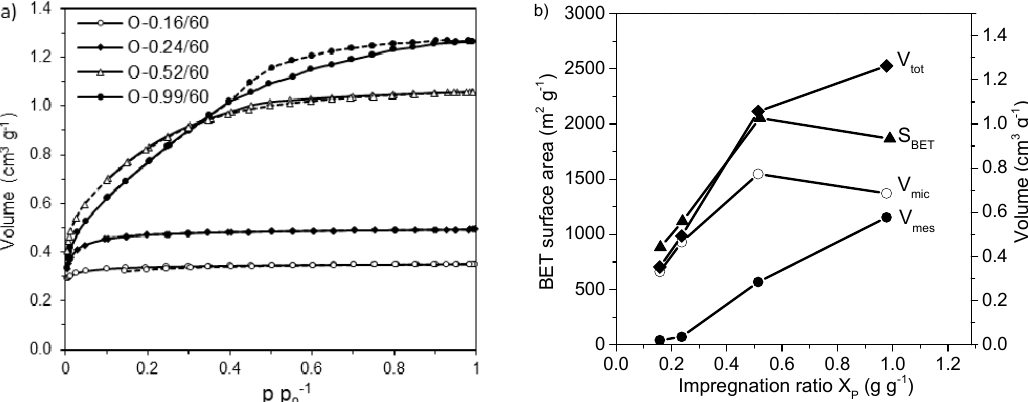
Figure 15. Adsorption (-) and (---) desorption N 2 isotherms at 77 K ( a ) and variations in the BET surface area (S BET ), total pore volume (V T ), micropore volume (V mic ), mesopore volume (V mes ) ( b ) for ACs from oak prepared by phosphoric acid activation at different impregnation ratio (g P/g precursor). Reproduced from [4] with permission from Elsevier © 2007.